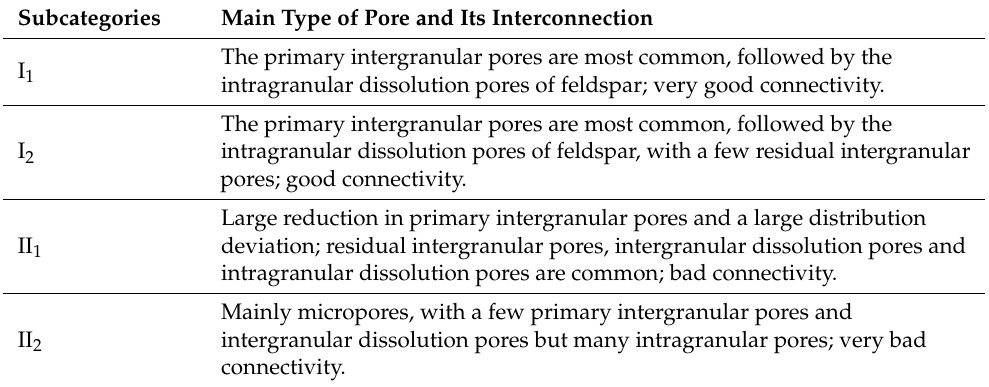
Table A7. Characteristics of the capillary pressure curve of different sandstone subcategories. Subcategories Characteristics Lower left distribution, skewed to coarse pore throats; very centralized pore throat distribution; few fine pore throats with diameters smaller than 1.6 µ m, I 1 peak of coarse pore throats with diameters of 4 to 6 µ m has a higher peak; nearly all of the pores throats contribute to permeability. Slightly lower left distribution, slightly skewed to coarse pore throats; centralized pore throat distribution, with few fine pore throats with I 2 diameters smaller than 1.0 µ m; peak of coarse pore throats with diameters of 1 to 4 µ m has a higher peak; most pores and pore throats contribute to permeability. Slightly upper right distribution, slightly skewed to fine pore throats; discrete pore throat distribution, with few fine pore throats with diameters II 1 smaller than 0.063 µ m; peak of coarse pore throats with diameters of 0.63 µ